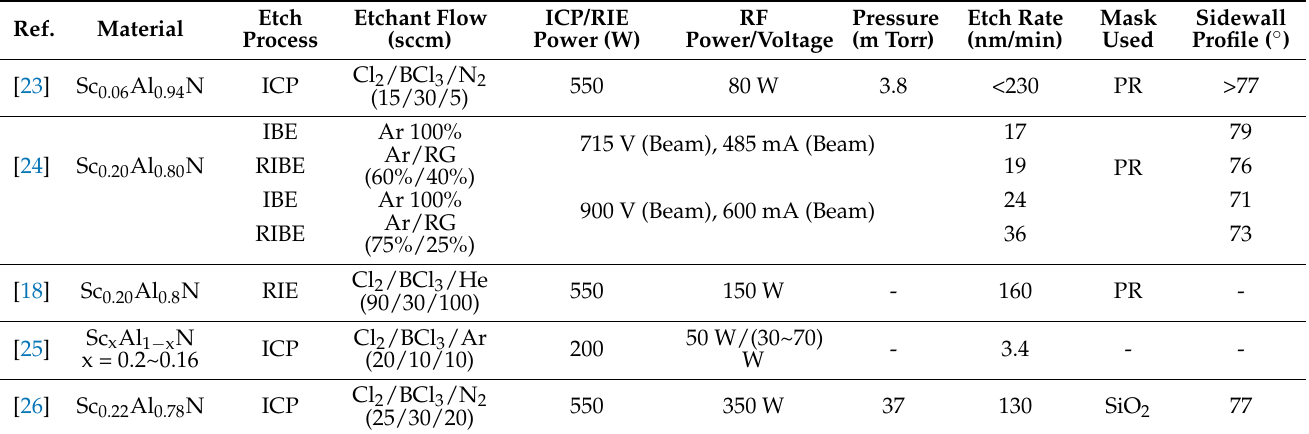
Table 1. Summary Sc x Al 1 − x N dry etching process